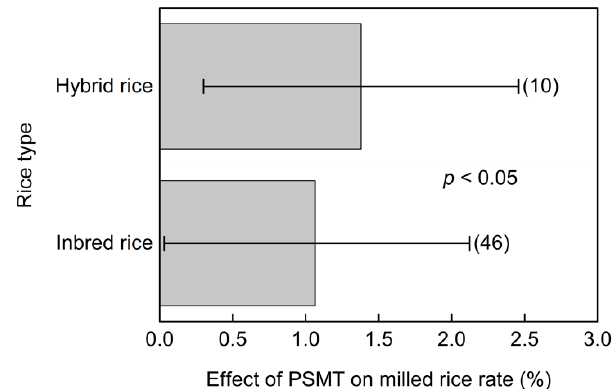
Figure 5. Effects of potted-seedling machine transplantation (PSMT) on milled rice rate as affected by rice types in paddies. The numbers near the error bars denote the number of observations for each variable. Error bars represent 95% confidence intervals, and p values indicate the results of a Wald-type test for differences between classes.